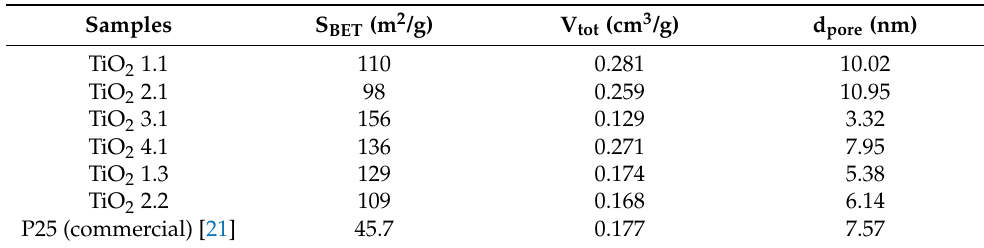
Table 2. Textural parameters * resulted from N 2 adsorption-desorption isotherms of synthesized titania samples.